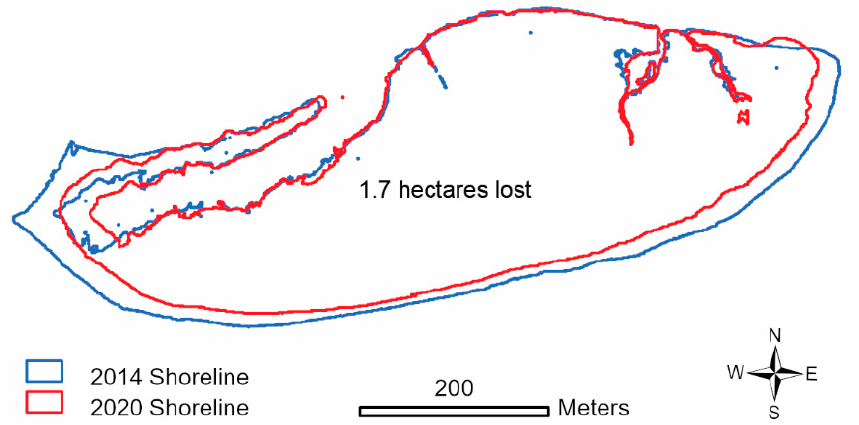
Figure 3. Shorelines derived from object-based image analysis techniques, where blue indicates 2014 and red indicates